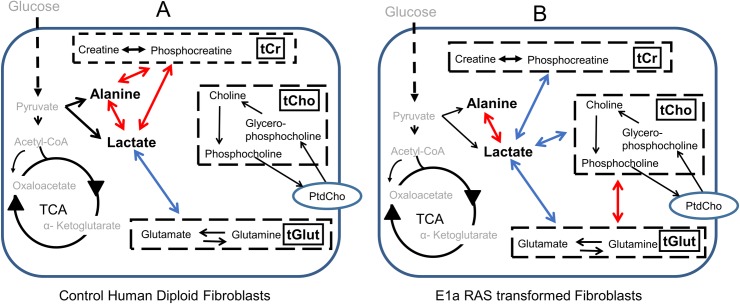
Metabolite-Metabolite correlations in cultured human diploid fibroblasts.A). Control cells B). E1A-Ras transformed cultured cells. Data adapted from Madhu et al [7].